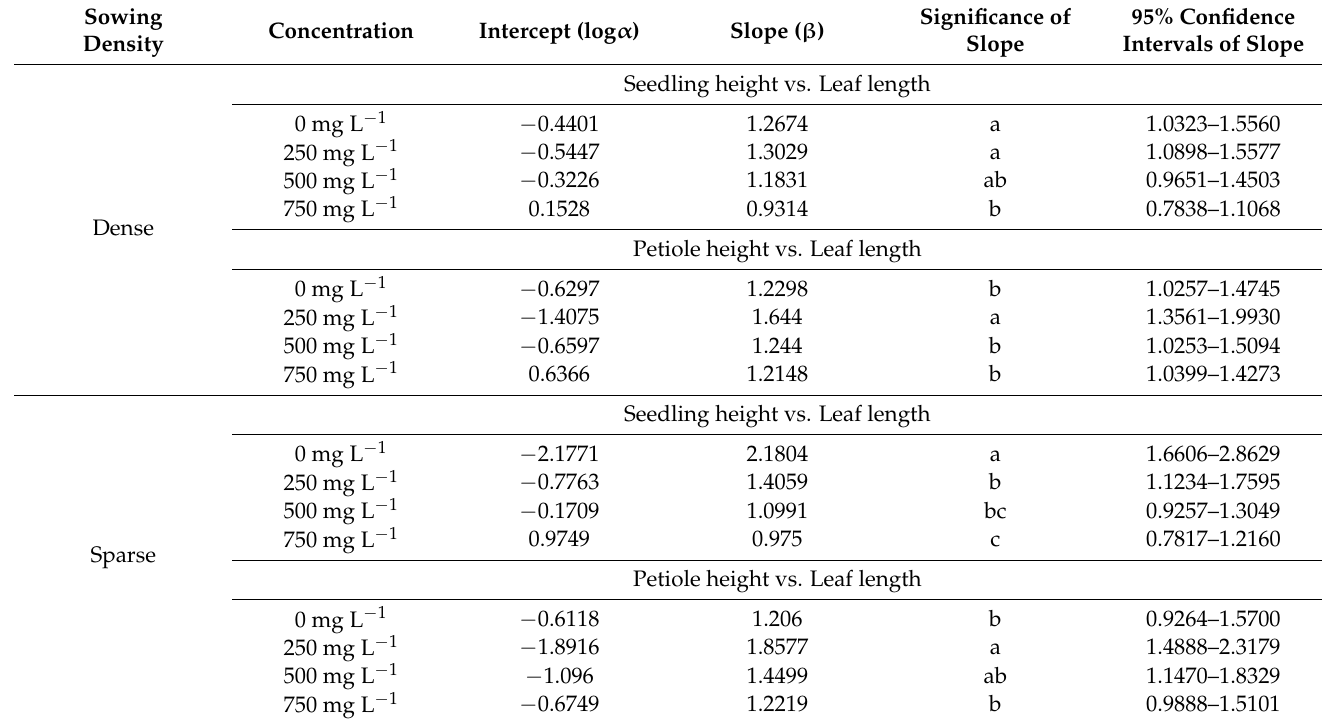
Table 3. Standardized major axis (SMA) regression results for the effect of treatments on the allometric relationships between plant